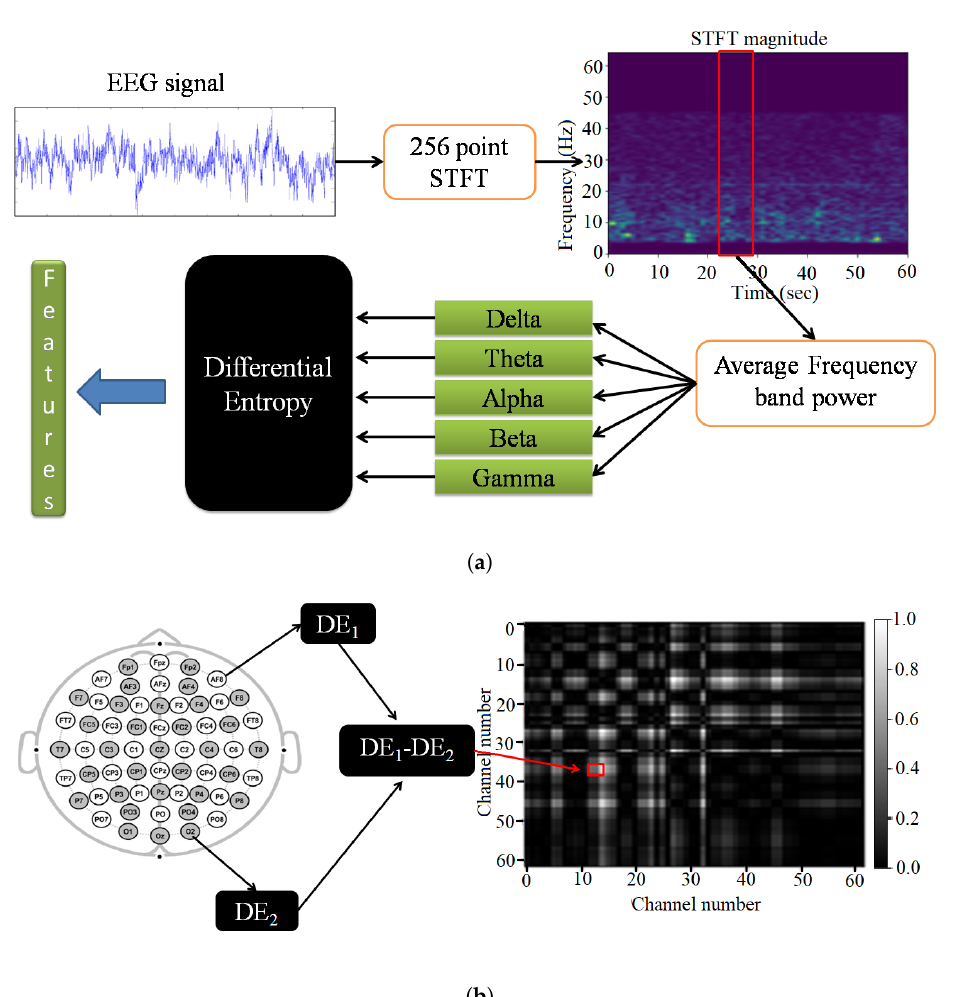
Figure 1. Pictorial representation of the steps involved in ( a ) manual feature extraction and ( b ) gener- ation of